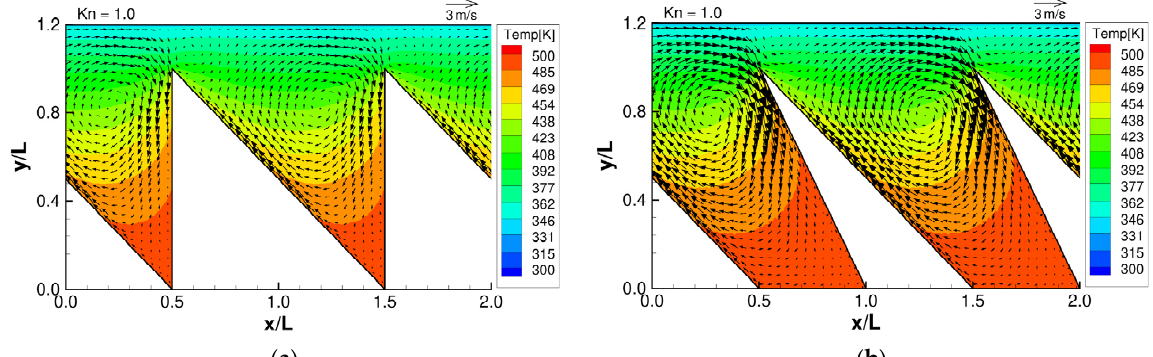
Figure 3. Flow distributions and temperature distributions for ( a ) ratchet, ( b ) modified ratchet, ( c ) oblique plate, and ( d ) oblique ridge, at Kn = 0.1 .